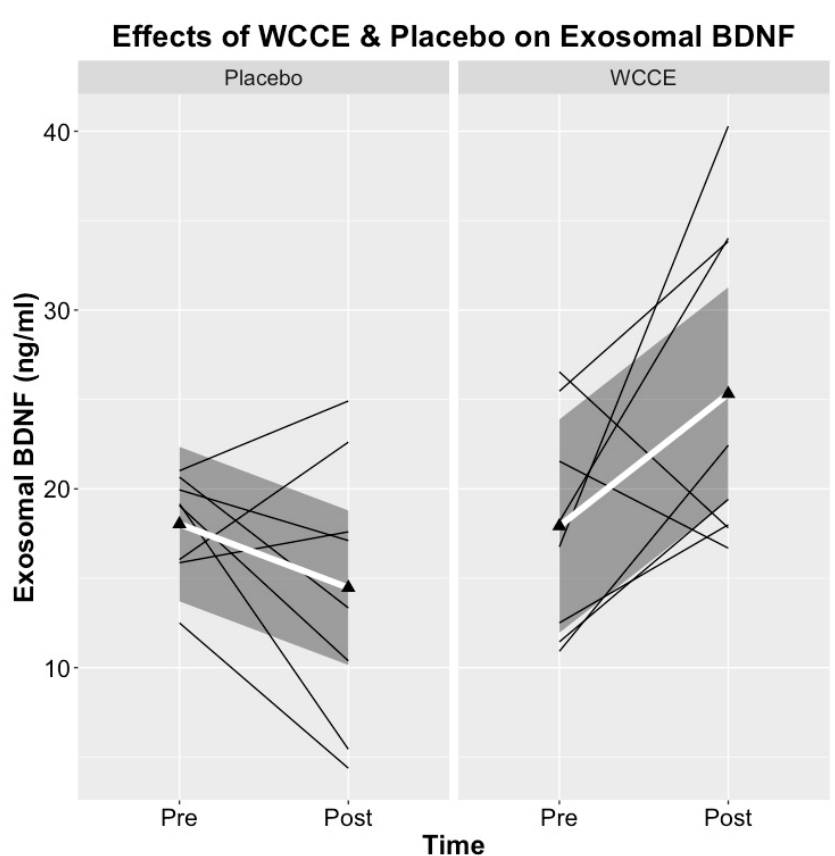
Figure 7. Pre- and post-consumption data for exosomal brain-derived neurotrophic factor (BDNF). Thin black lines indicate individual participant data, while the thicker white line depicts the group average. The dark gray shading surrounding the white line uses locally weighted regression (loess) for a visualization of group variability. Line graphs were created with open-source software ggplot2 in R.